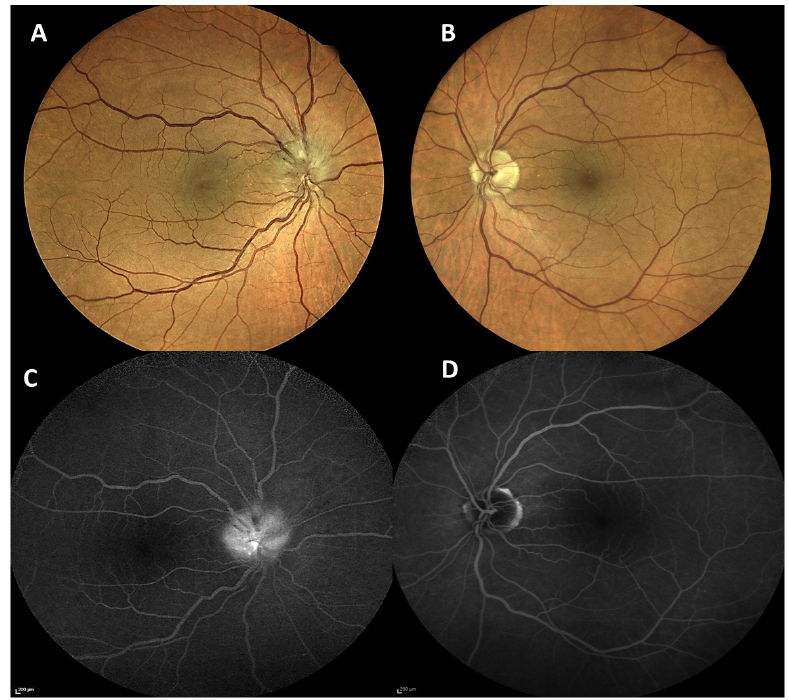
Figure 4. Fundus photography ( A , B ) showed an elevated and congested optic nerve head in the right eye ( A ) and was normal in the left eye ( B ). Late fundus fluorescein angiography ( C , D ) revealed a staining at the optic nerve head in the right eye ( C ) and was unremarkable in the left eye ( D